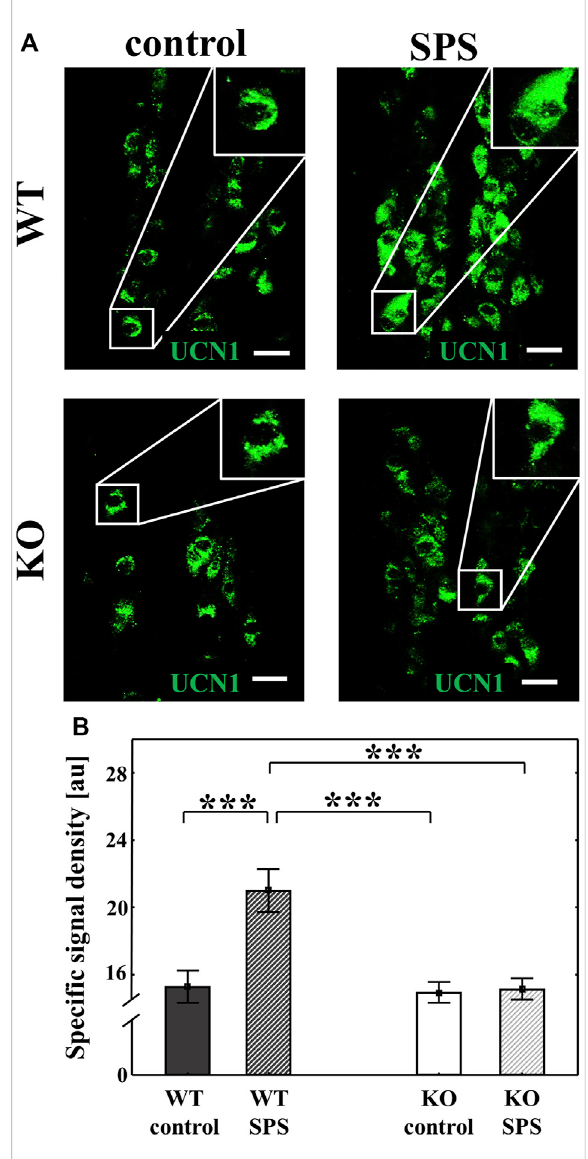
FIGURE 6 Effects of single prolonged stress (SPS) on the urocortin 1 (UCN1) peptide content of the centrally projecting Edinger- Westphal nucleus (EWcp) neurons. Representative confocal images of the UCN1 (green) immuno fl uorescence in the EWcp neurons. Scale bars: 25 µm (A) . Columns represent the speci fi c signal density of urocortin 1 peptide/neuron (B) (two-way ANOVA followed by Tukey ’ s post-hoc test; *** p < 0.001; n = 8/ group). au: arbitrary unit, WT: wild type, KO: